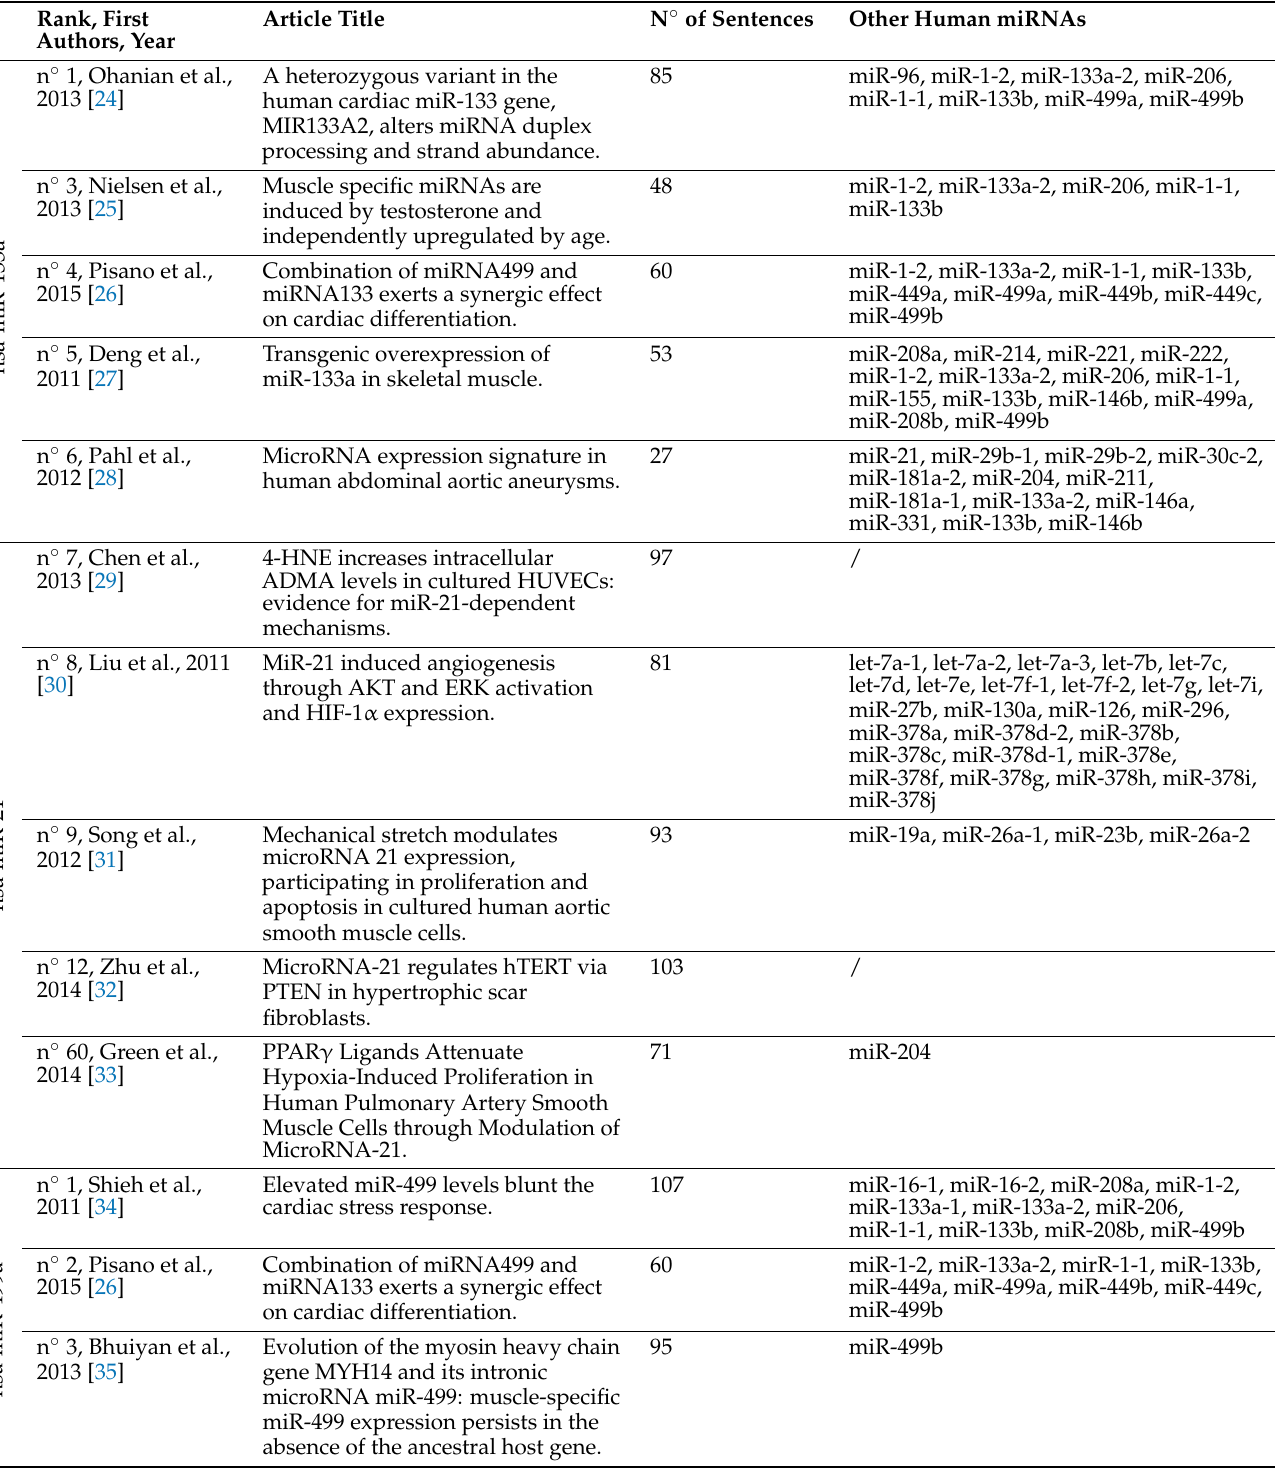
Table 2. The top 5 selected, ranked articles on the theme of this article for hsa-miR-133a-3p, hsa-miR- 21-5p, hsa-miR-499a-5p, hsa-miR-1-3p, and hsa-miR-126-3p; additionally, the number of sentences associated with the microRNA’s name, and other human microRNAs that were screened in the study have been